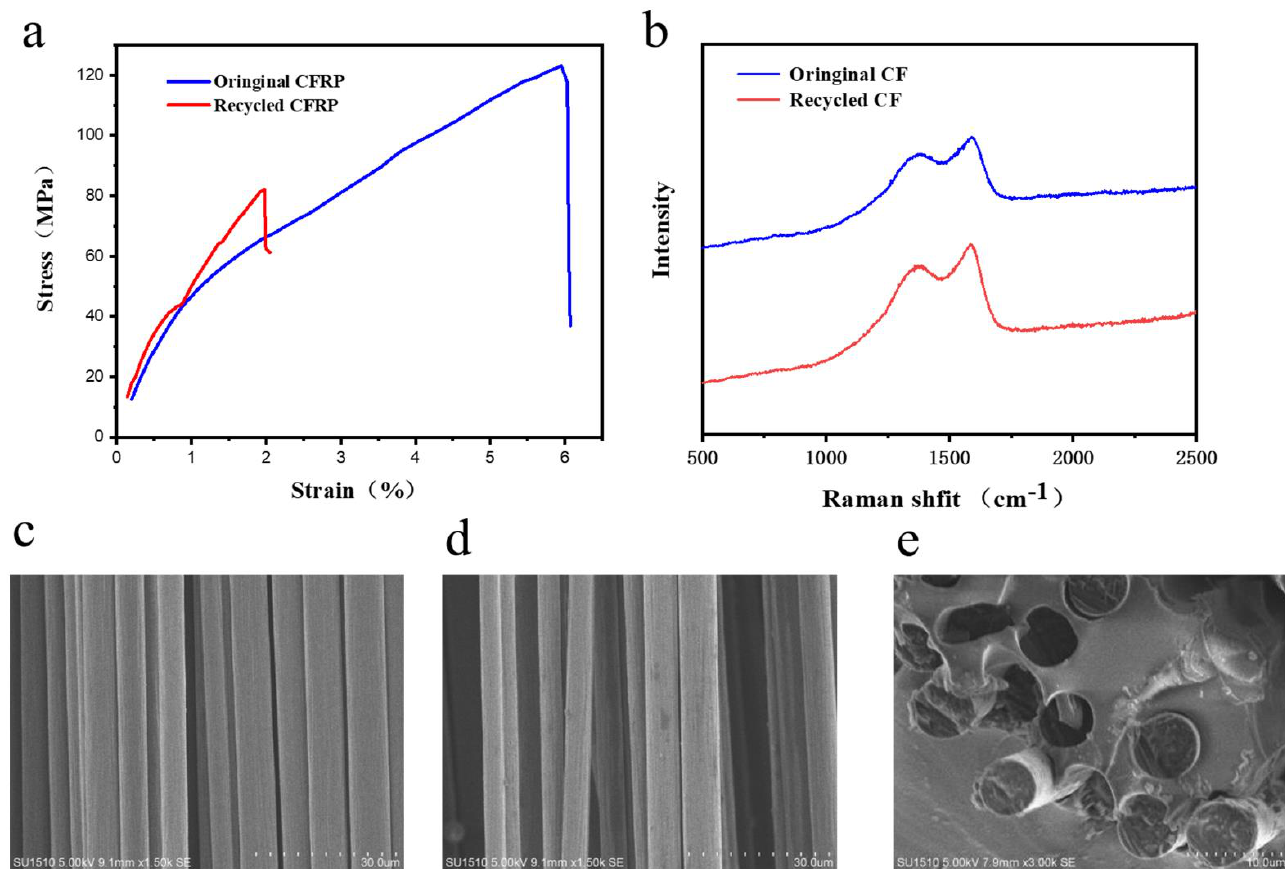
Figure 9. ( a ) Stress-strain curves of original CFRP and recycled CFRP; ( b ) Raman spectra of original CFRP and recycled CFRP. SEM images of ( c ) original CFRP, ( d ) recycled CFRP and ( e ) CFRP cross section.